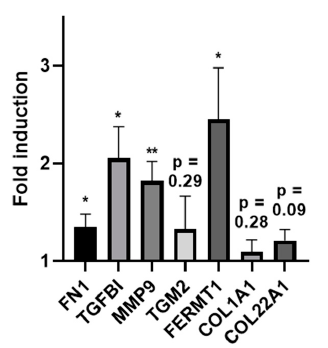
Figure 5. Induction of ECM-related proteins in human skin explants treated with PRGF. Human skin explants derived from surgery were treated with PRGF for approx. 20 h. Gene expression was analyzed by real-time PCR and results are shown as fold-induction compared to the unstimulated control. Shown are the means of 4 independent experiments with skin explants derived from 4 di ff erent donors (* p < 0.05, ** p < 0.01; Student’s t